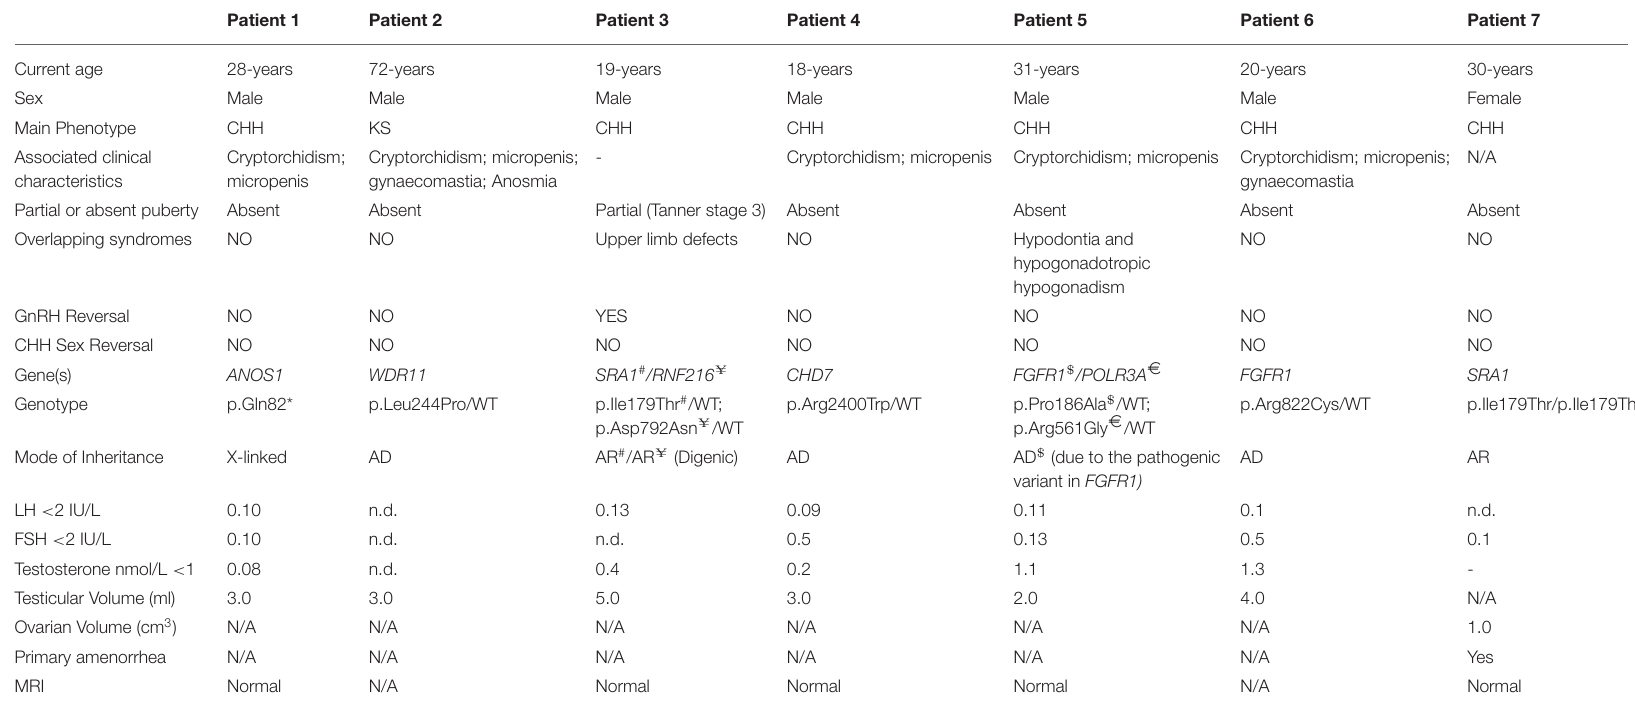
TABLE 1 | Clinical and biochemical characteristics of the patients with